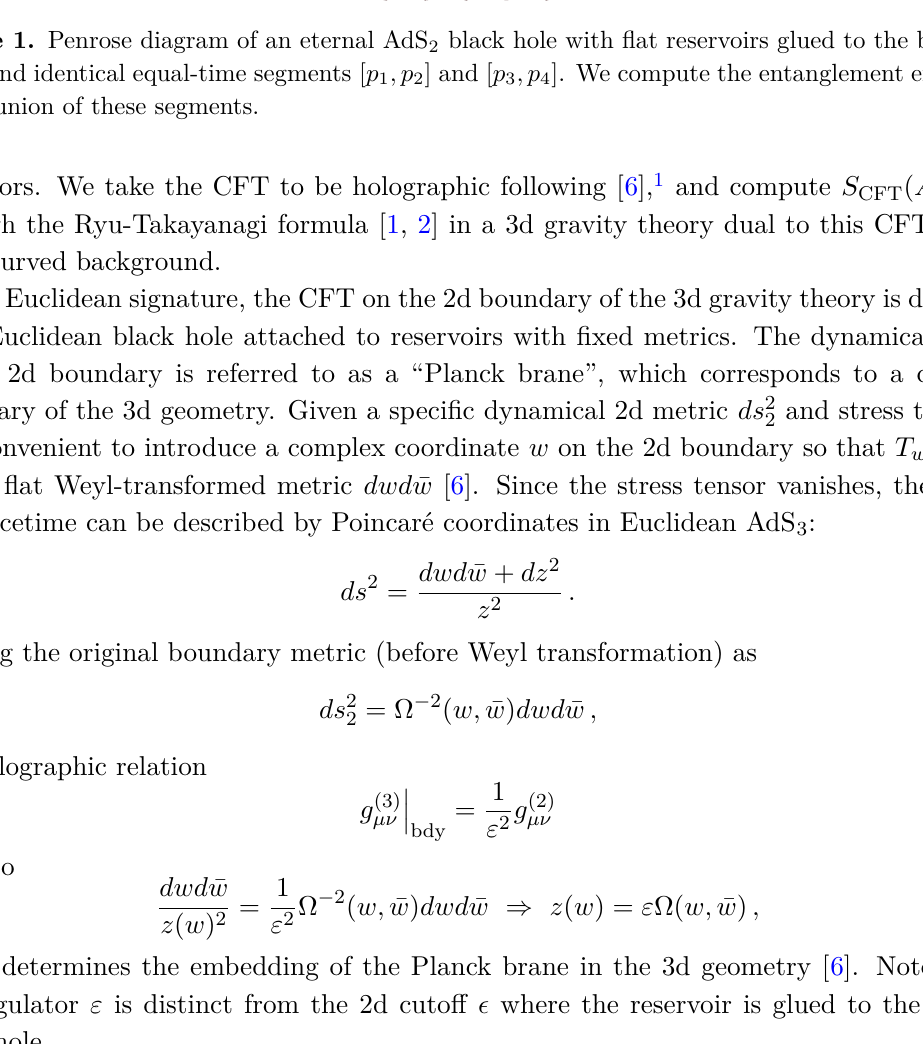
] and [ p ] . We compute the entanglement entropy 1 , p 2 3 , p 4